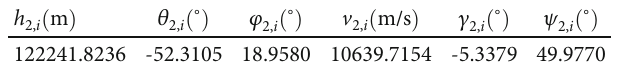
Table 5: Initial states of the aerocapture